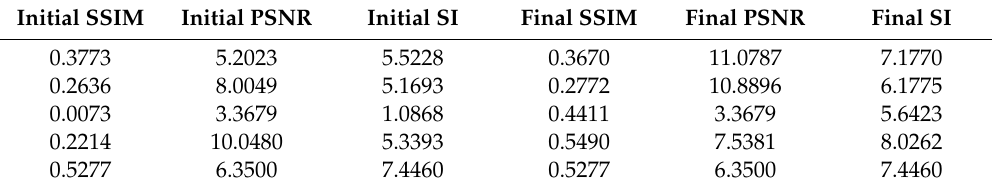
Table 1. Five enhanced results.